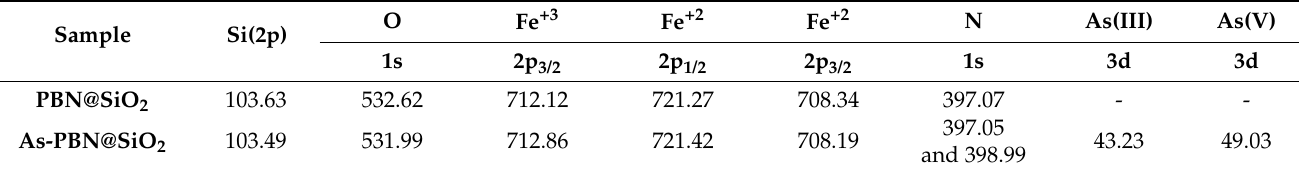
Table 3. XPS data of PBN@SiO 2 and Arsenic-PBN@SiO 2